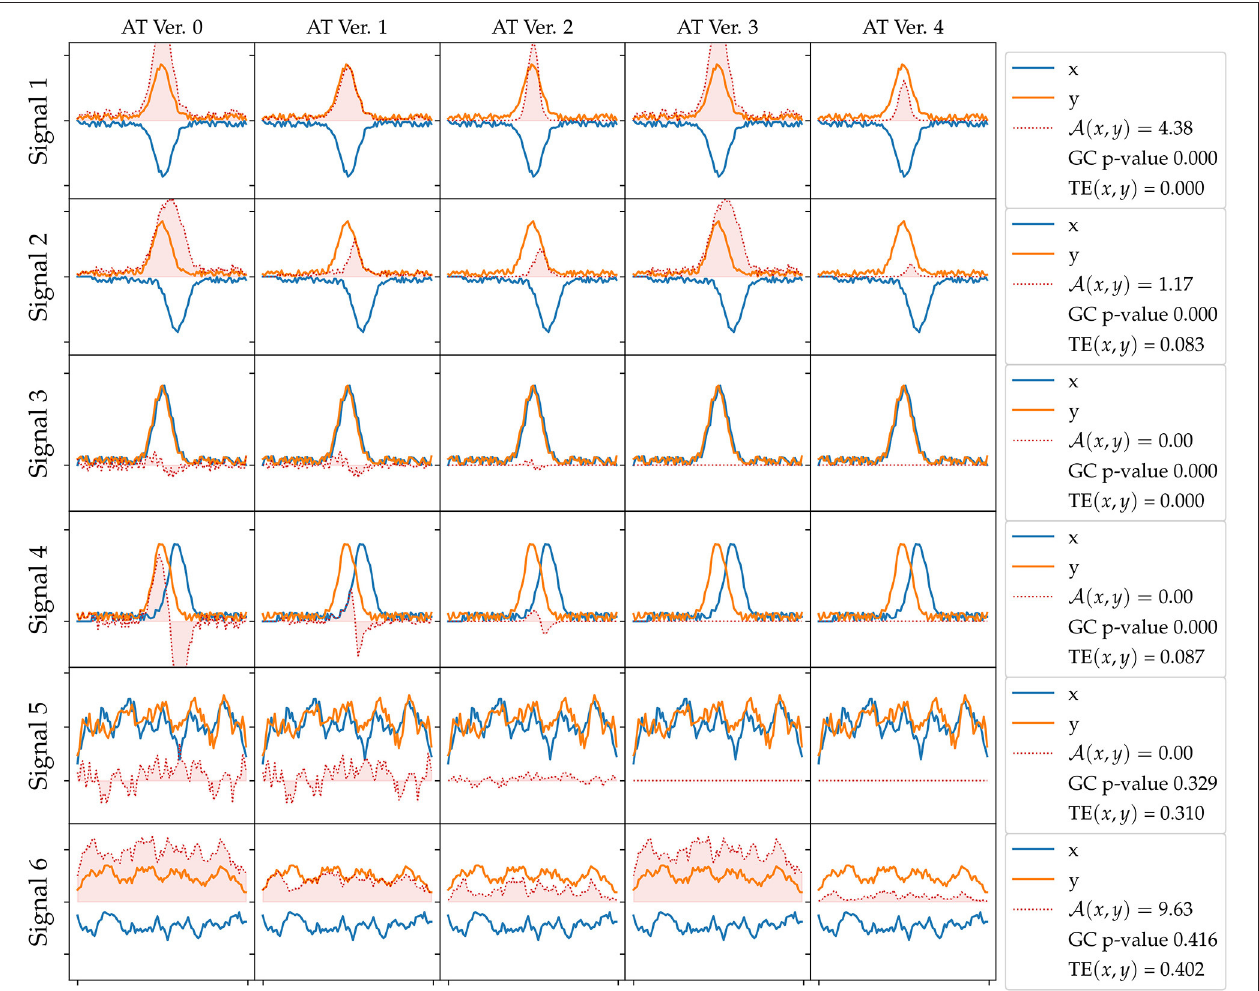
FIGURE 4 | Acceleration Transfer (AT) measure versions evaluated on different synthetic generated signals. The rows correspond to different generated signals: 1) two Gaussians of opposite signs, 2) two Gaussians of opposite signs with a lag, 3) two Gaussians of the same sign, 4) two Gaussians of the same sign with a lag, 5) random smoothed signals, 6) random smoothed signals of opposite signs. The columns correspond to the different versions of the AT (refer to text for further details): V0) signal subtraction, V1) filter by minimum value, V2) filter by closeness to 0, V3) filter by value sign, and V4) all Filters included. In the legend at each row, we show the AT value, the Granger Causality (GC) p -value, and transfer entropy (TE) for each signal. A GC p < 0.05 means x signal Granger causes y . TE is in